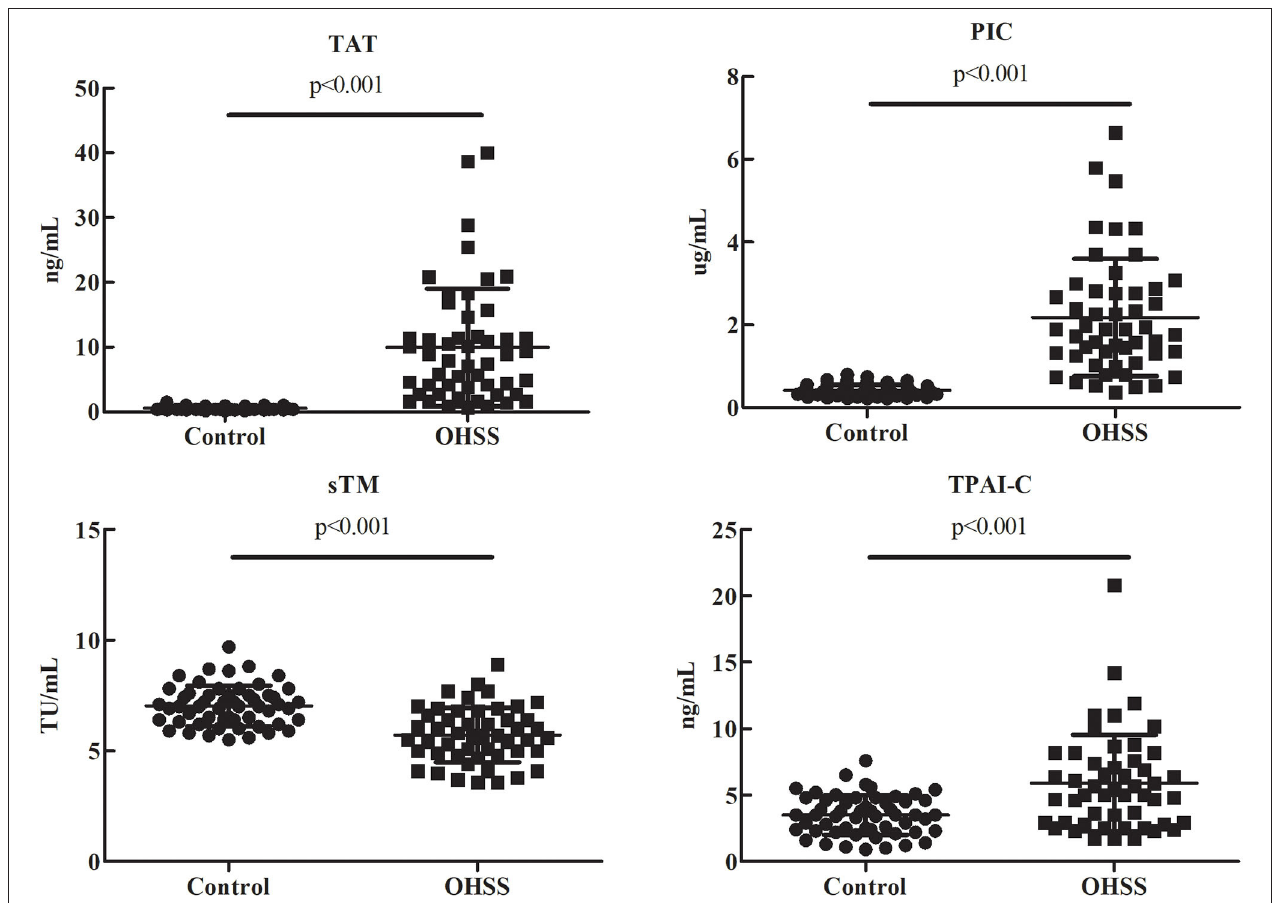
FIGURE 1 | Comparisons of the thrombin-antithrombin complex, plasmin alpha2-plasmin inhibitor complex, soluble thrombomodulin, and tissue plasminogen activator-inhibitor complex levels in patients with ovarian hyperstimulation syndrome and control patients. TAT, thrombin-antithrombin complex; PIC, plasmin alpha2-plasmin inhibitor complex; sTM, soluble thrombomodulin; TPAI-C, tissue plasminogen activator-inhibitor complex; OHSS, ovarian hyperstimulation